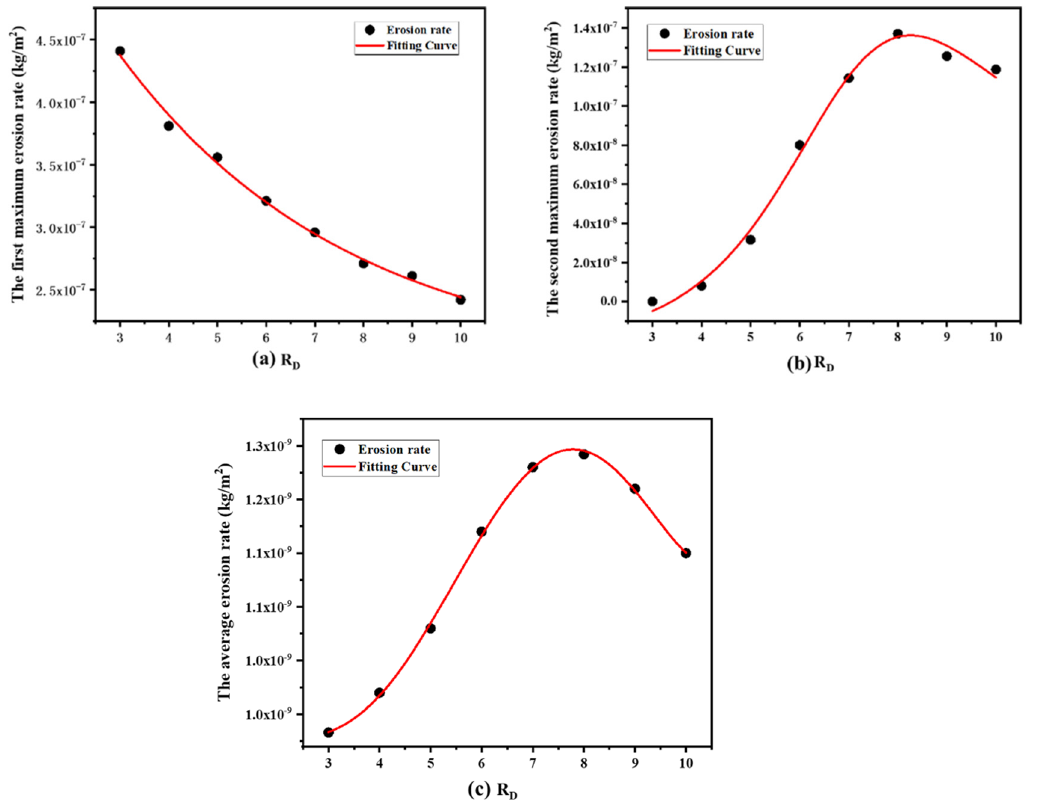
Figure 18. Fitting curves of erosion rate corresponding to different curvature ratios: ( a ) Primary maximum erosion rate with different curvature ratios ( b ) Secondary maximum erosion rate with different curvature ratios ( c ) Average erosion rate with different curvature ratios.